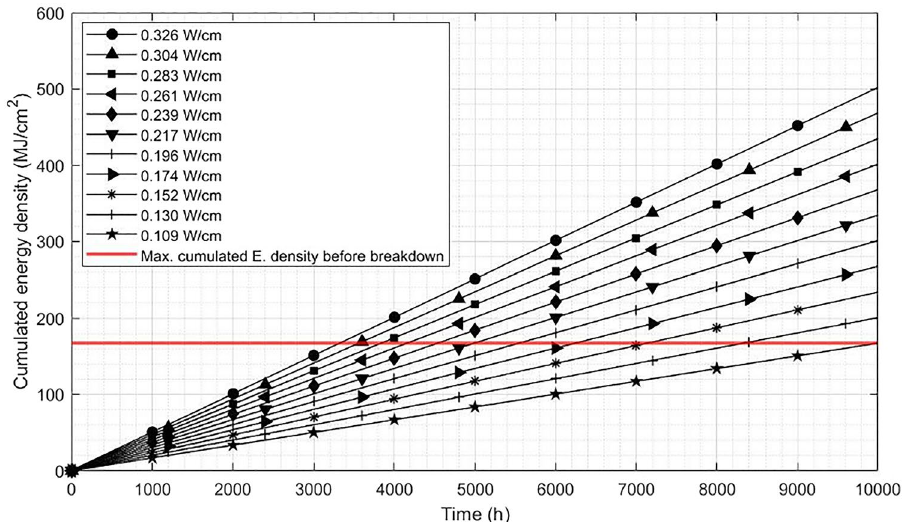
Figure 6. Service life prediction for different levels of power density on wire